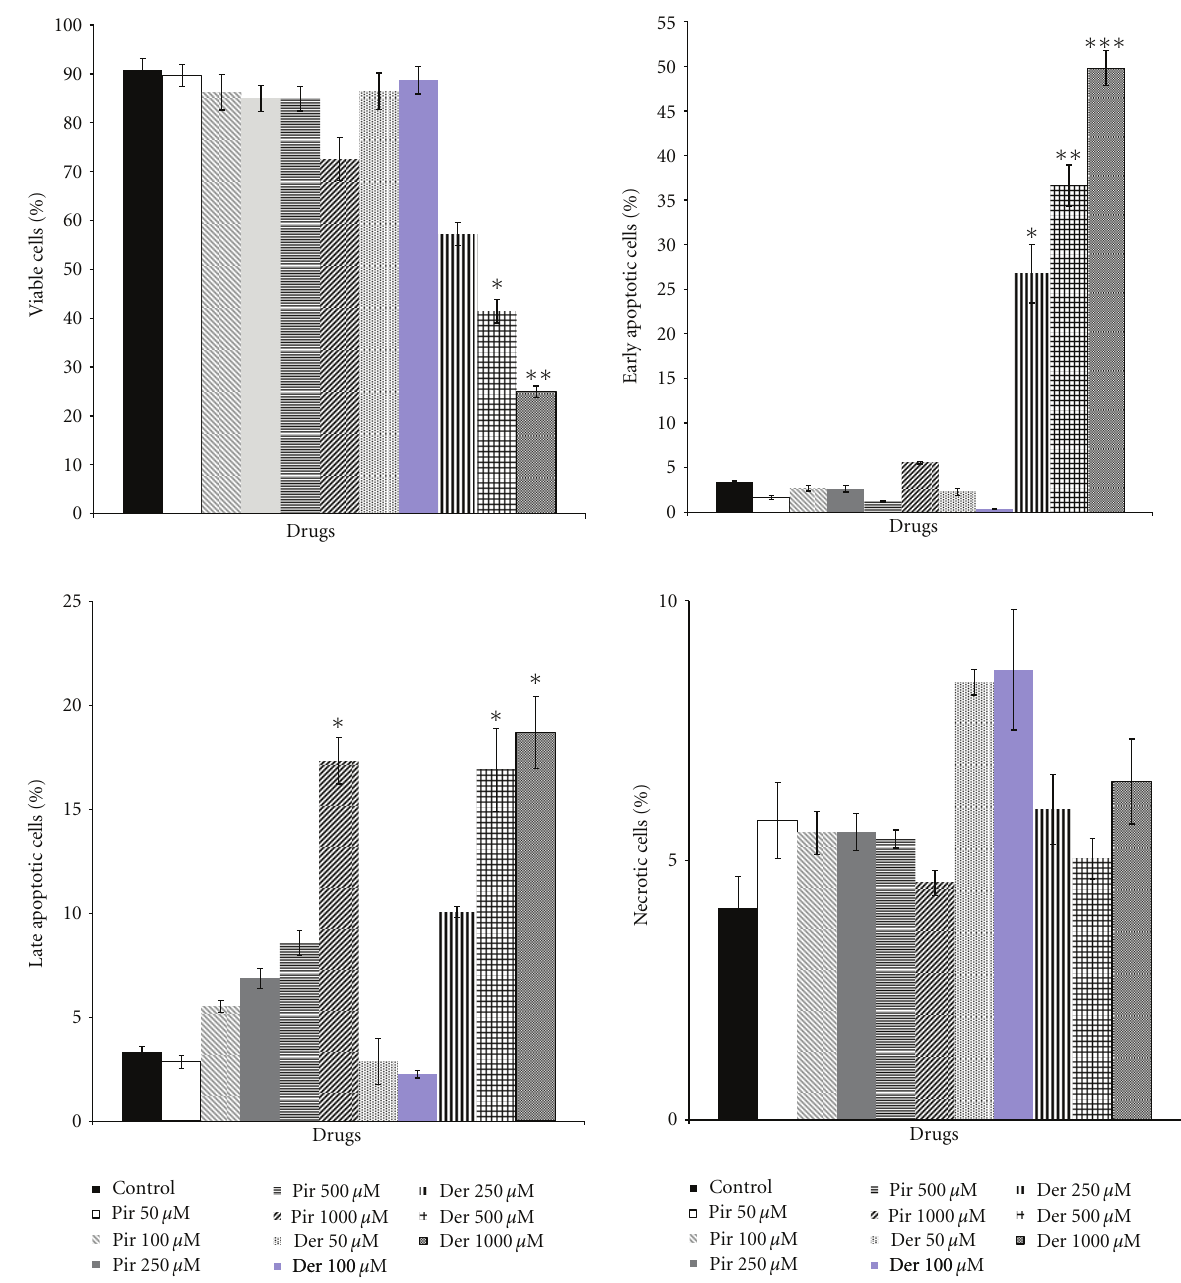
Figure 3: Flow cytometric analysis of apoptosis of CMT-U27 cells after treatment with piroxicam (Pir) and deracoxib (Der) for 72h. Data are expressed as mean values ± standard error of means shown with ∗ P < 0 . 05, ∗∗ P < 0 . 01, and ∗∗∗ P < 0 . 001 versus control group ( n =